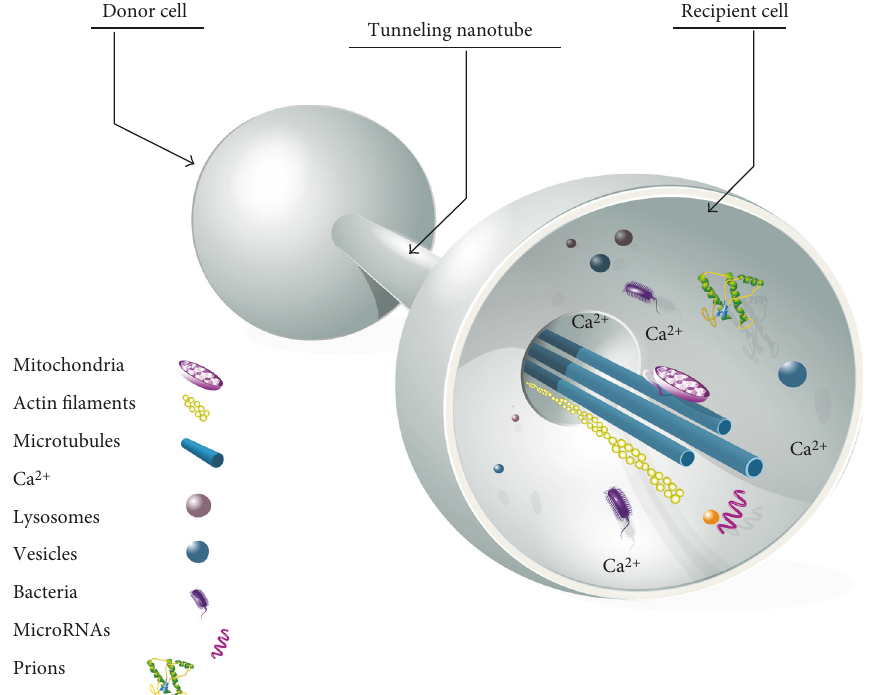
Figure 1: Tunneling nanotube (TNT). Tunneling nanotubes can connect many di ff erent cells together, using cytoskeleton actin micro fi laments, microtubules, or both. TNTs allow the tra ffi cking, from donor to recipient cells, of cargoes including organelles, proteins, miRNAs, and